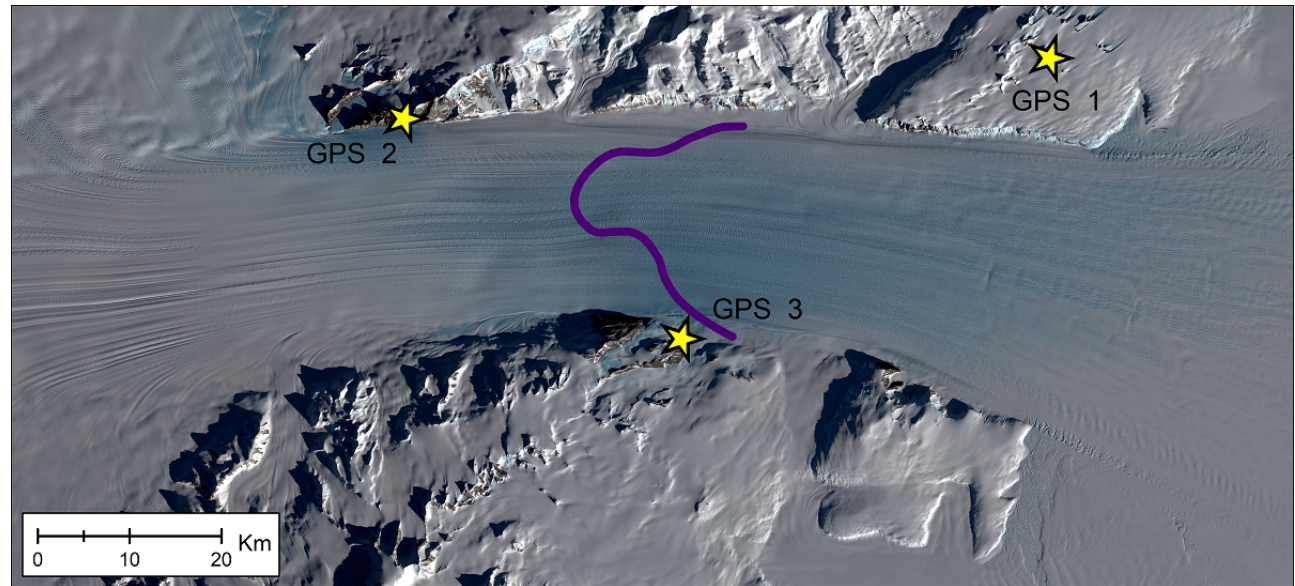
Figure 5. GPS sites on stable rock locations represented by stars. The violet line located near the middle of the glacier’s trunk is the grounding line estimated from 2013 GPS data and 2017 surface elevations [51]. The methodology for identifying the grounding line is similar to Fricker et al. [52] and Brunt et al.